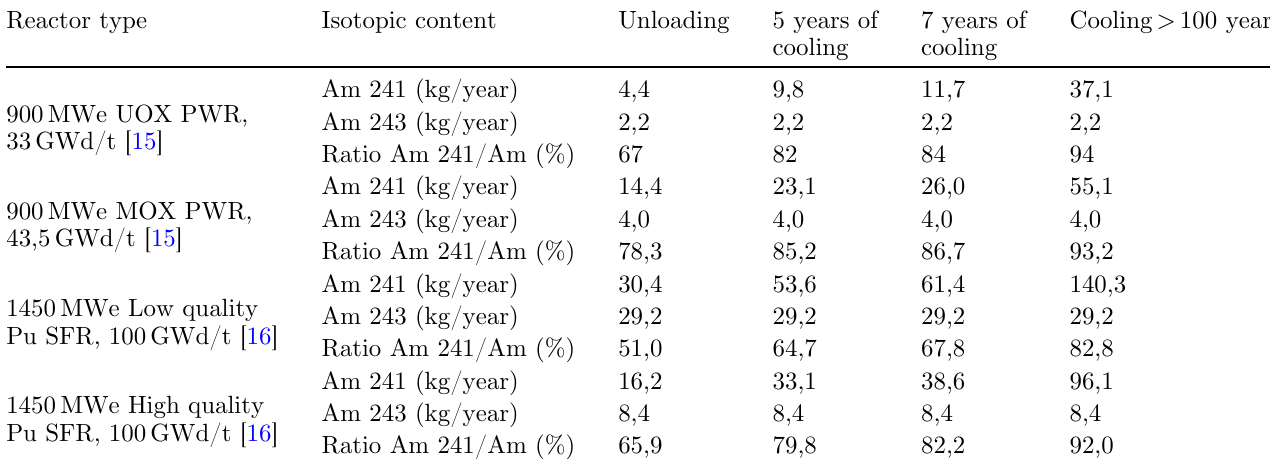
Table 3. Americium isotopic content for various cases depending on the reactor type and burn-up Reactor